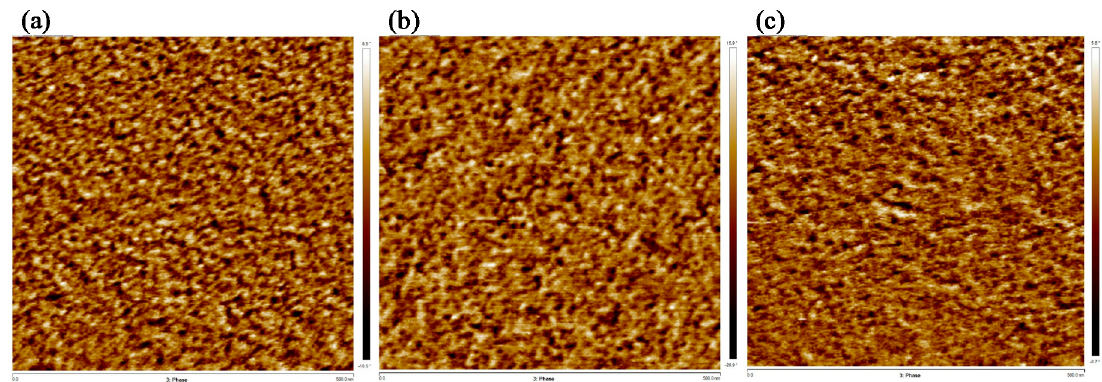
Figure 5. AFM images of the (PIM-PI)-(6FDA-durene-PI)(1:4) ( a ) and (PIM-PI)-(6FDA-durene-PI)(1:6) ( b ) and (PIM-PI)-(6FDA-durene-PI)(1:10) ( c ).